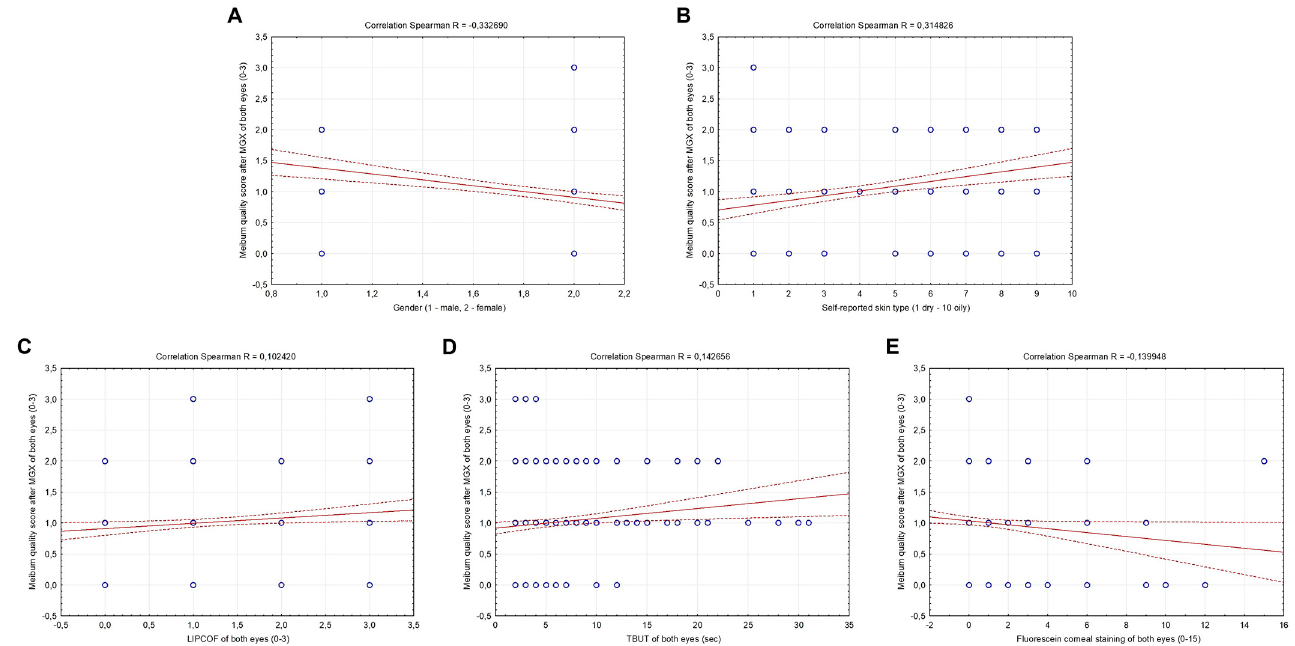
Figure 2. Correlations between the meibum quality score after MGX, gender ( A ), skin type ( B ), LIPCOF ( C ), TBUT ( D ) and fluorescein corneal staining ( E ) of both eyes in all subjects included in the